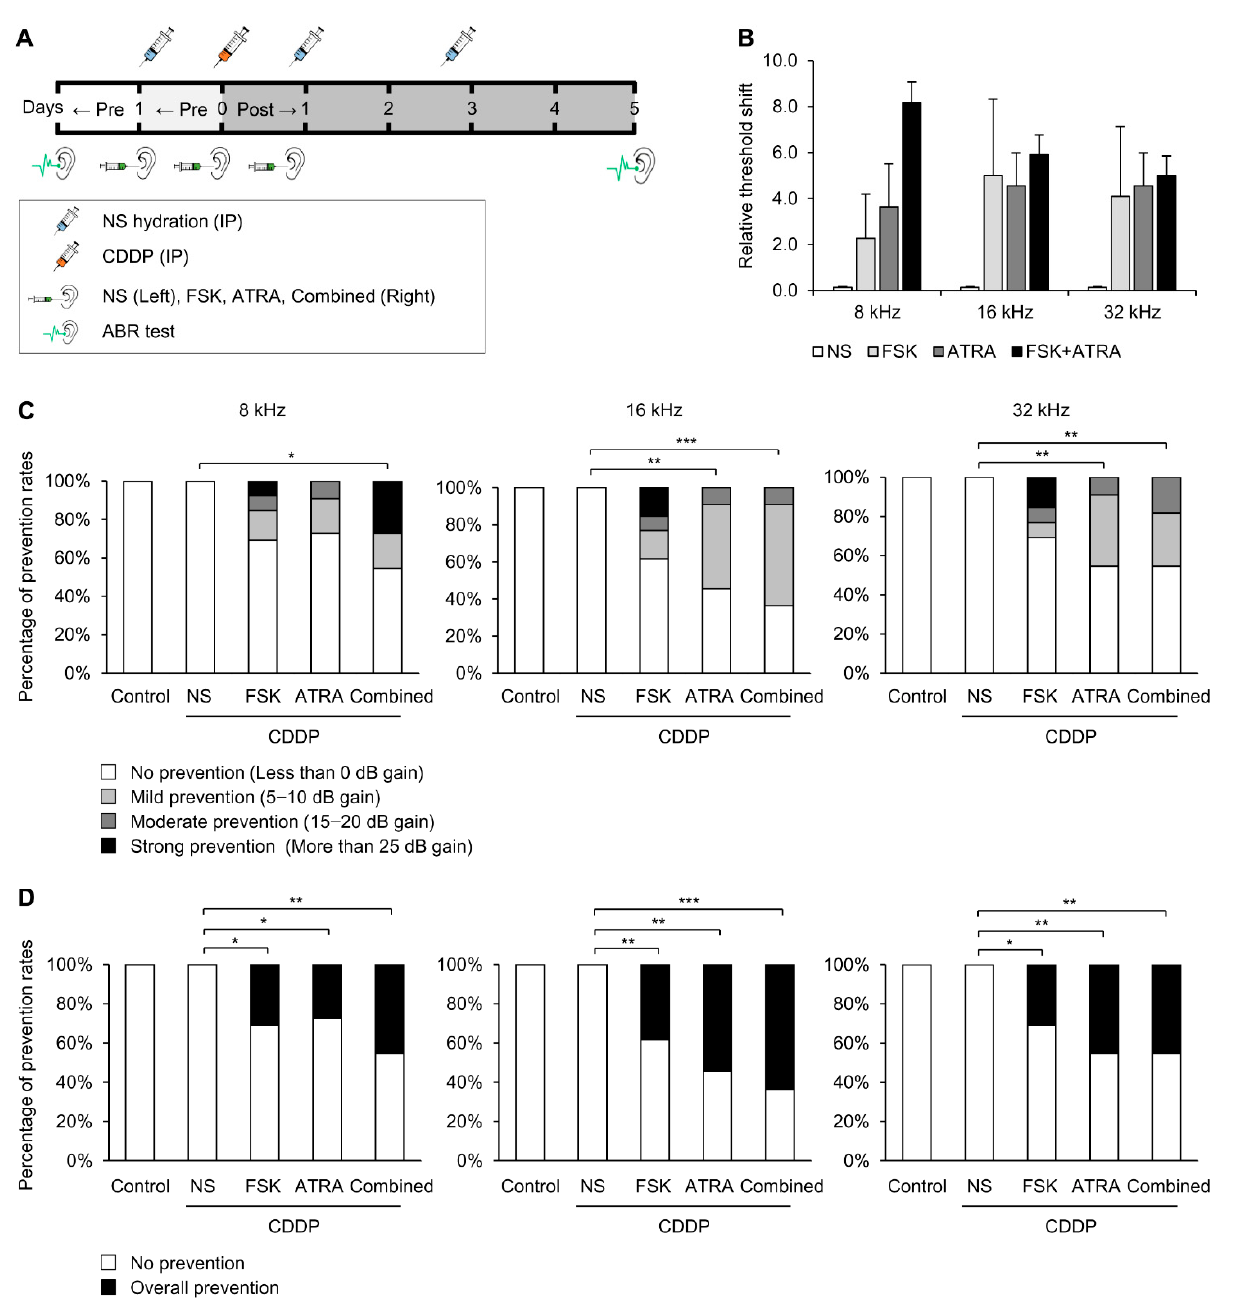
Figure 3. Comparison of hearing gain after FSK, ATRA, and combined treatment in terms of hearing loss prevention rates. All bar graphs show mean ± standard error (n = 11 per group). * p < 0.05, ** p < 0.01, *** p < 0.001. NS, normal saline; CDDP, cisplatin; FSK, forskolin; ATRA, all-trans retinoic acid; ABR, auditory brainstem response; IP, intraperitoneal; IT, intratympanic. ( A ) Experimental diagram of the in vivo animal studies conducted to investigate the effects of FSK, ATRA, and their combination on CDDP-induced ototoxicity. ( B ) Relative threshold shifts at 8, 16, and 32 kHz measured on day 5 after CDDP injection. ( C ) Comparison of hearing loss prevention rates. Hearing loss prevention rates were categorized as mild, moderate, or strong. ( D ) The overall hearing loss prevention rate is given as the sum of mild, moderate and strong